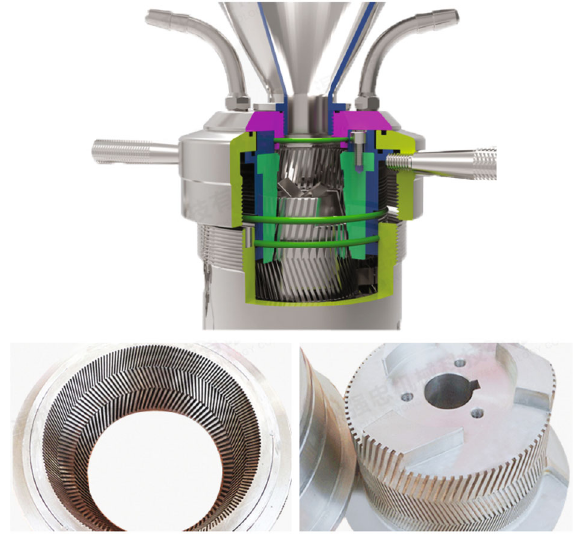
Figure 2: A commercial fi ne